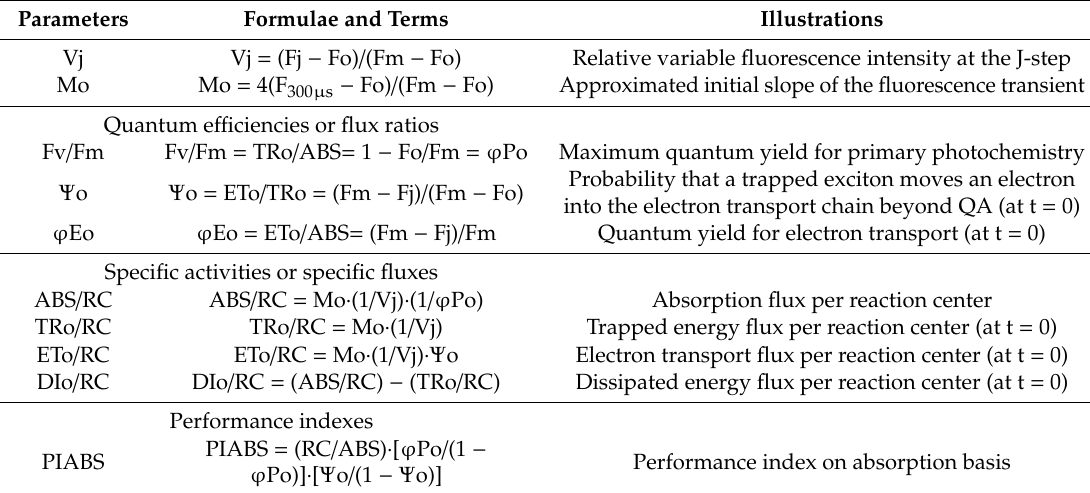
Table 1. The formulae and illustrations of the selected JIP test parameters in the study.